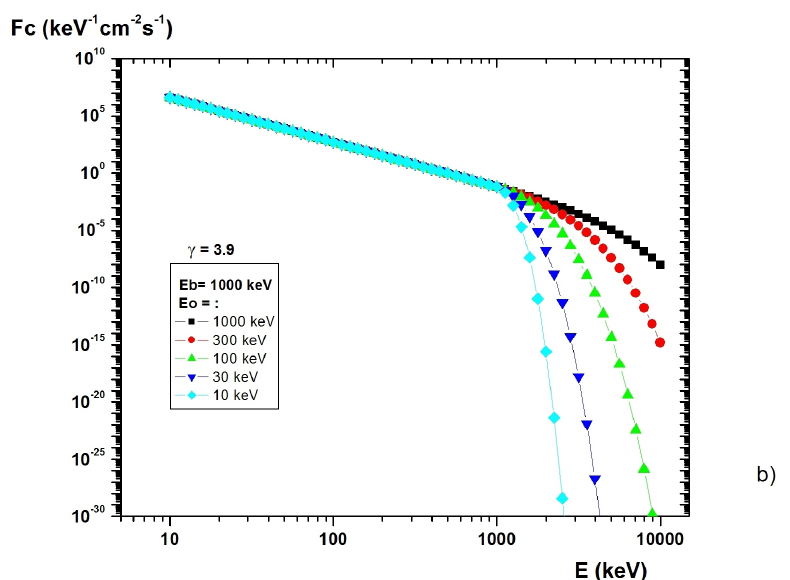
Figure 3. Energetic electron precipitation with an energy range from tens keV to several MeV fitted by combined spectral distribution F c ( E ) . Top panel, ( a ): combined spectral distribution F c ( E ) with a spectral index γ = 1. Bottom panel, ( b ): combined spectral distribution F c ( E ) with a spectral index γ = 3.9. The top panel ( a ) and bottom panel ( b ) have the same E o and E b , and the only difference is in a spectral index γ